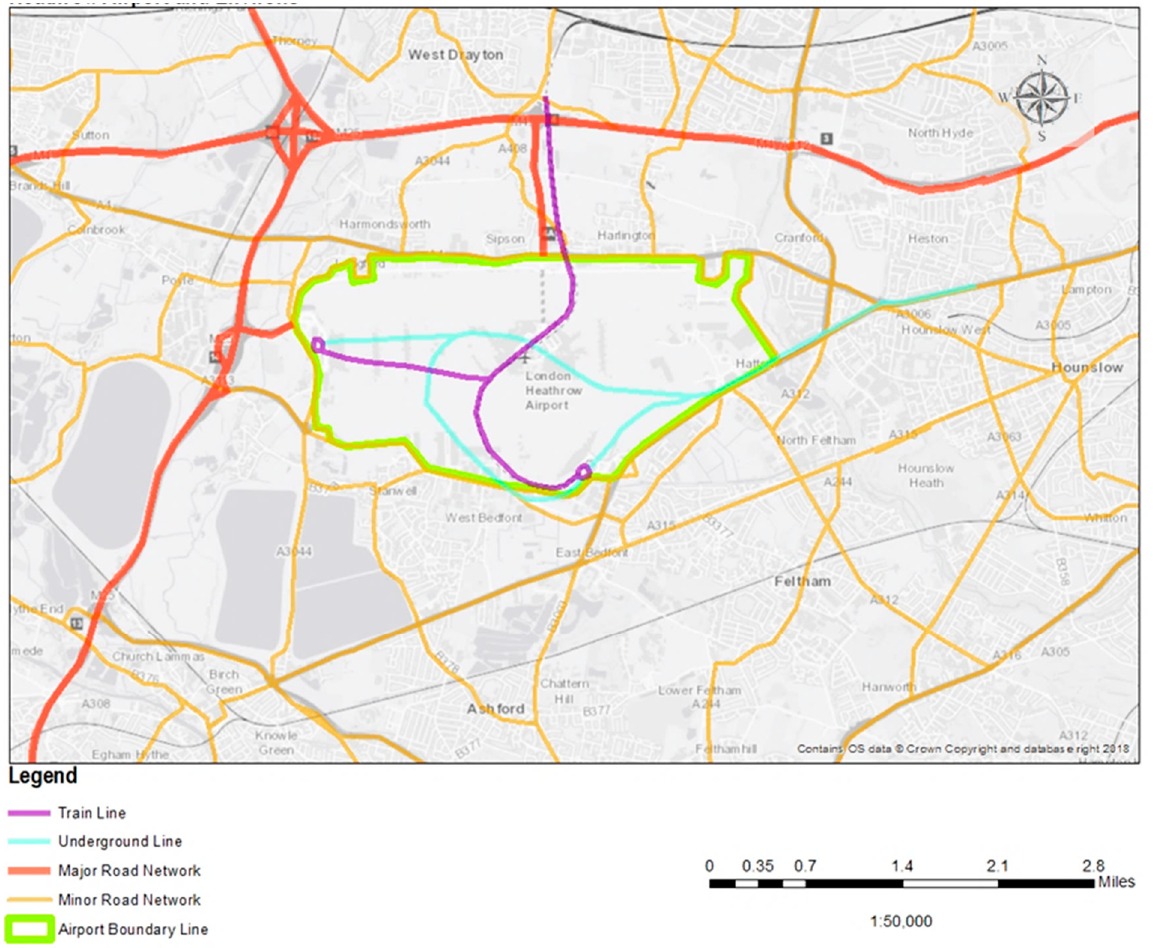
Figure 1. Map of Heathrow airport surface access connectivity and environs. (Source: Adapted from the online OSM 2018).